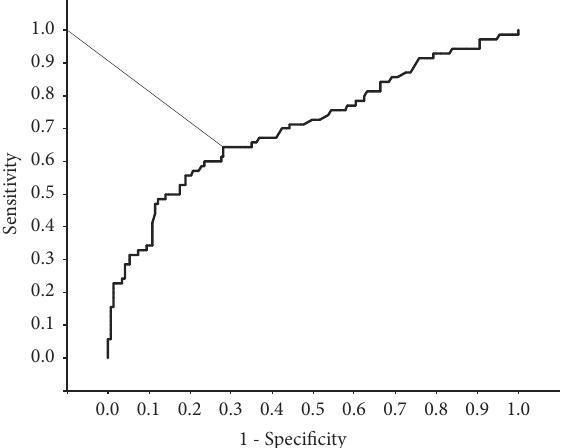
Figure 1: ROC curve of HOMA-IR for distinguishing GDM cases from the study group. HOMA-IR: homeostasis model assessment insulin resistance. GDM: gestational diabetes